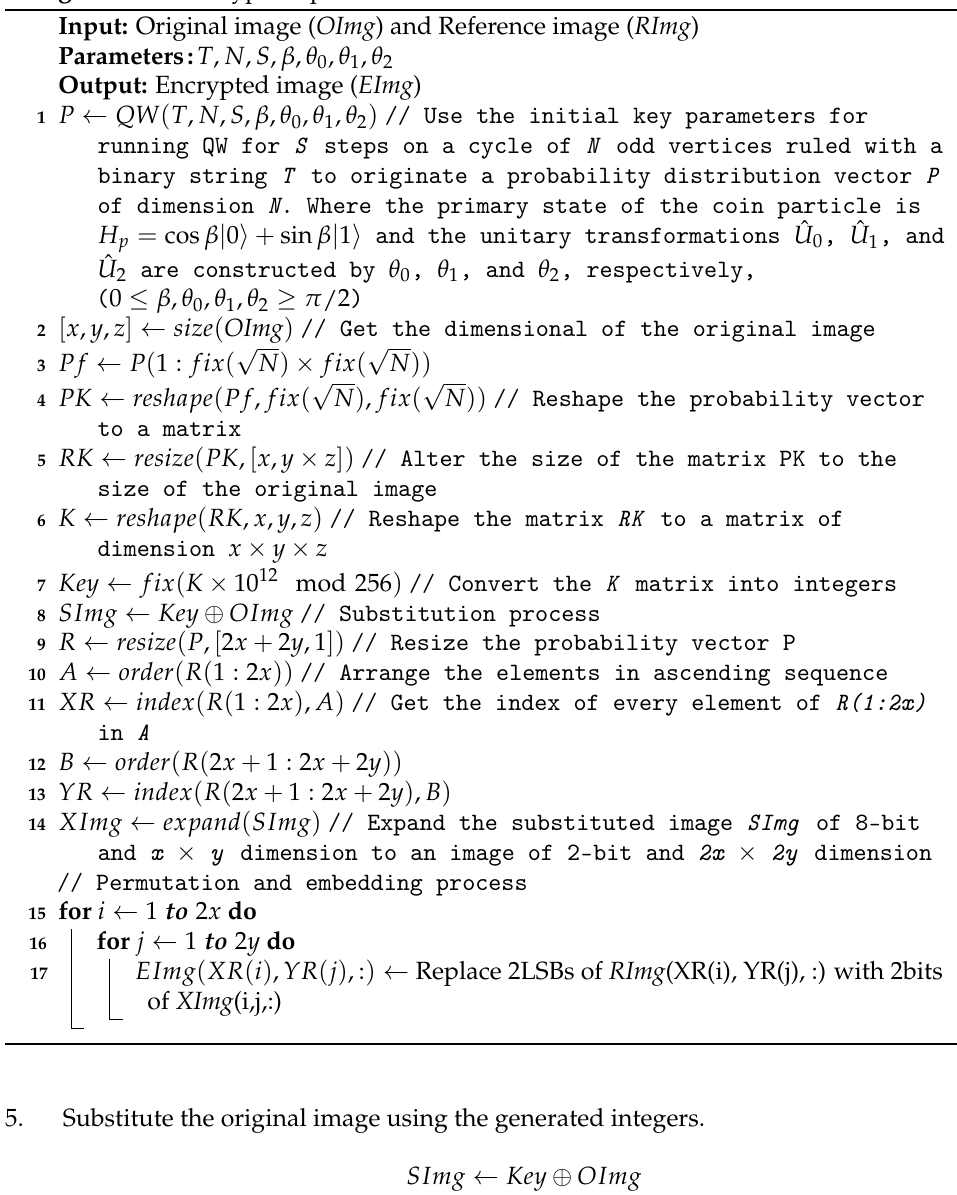
Algorithm 1: Encryption